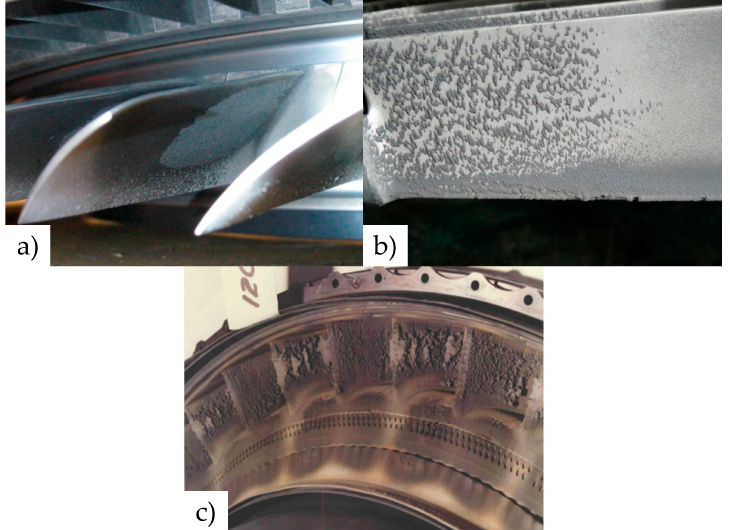
Figure 2. Some examples of fouling verification [52] ( a , b ), [53] ( c ). ( a ) Deposits on LPC blade; ( b ) Deposits on LPT vane; ( c ) Deposits of volcanic ash on the HPT nozzle guide vanes.